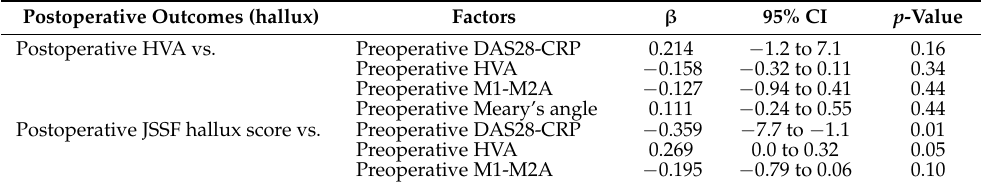
Table 6. Correlation coefficients between postoperative HVA or the JSSF hallux score and preoperative disease activity/radiographic measurements.